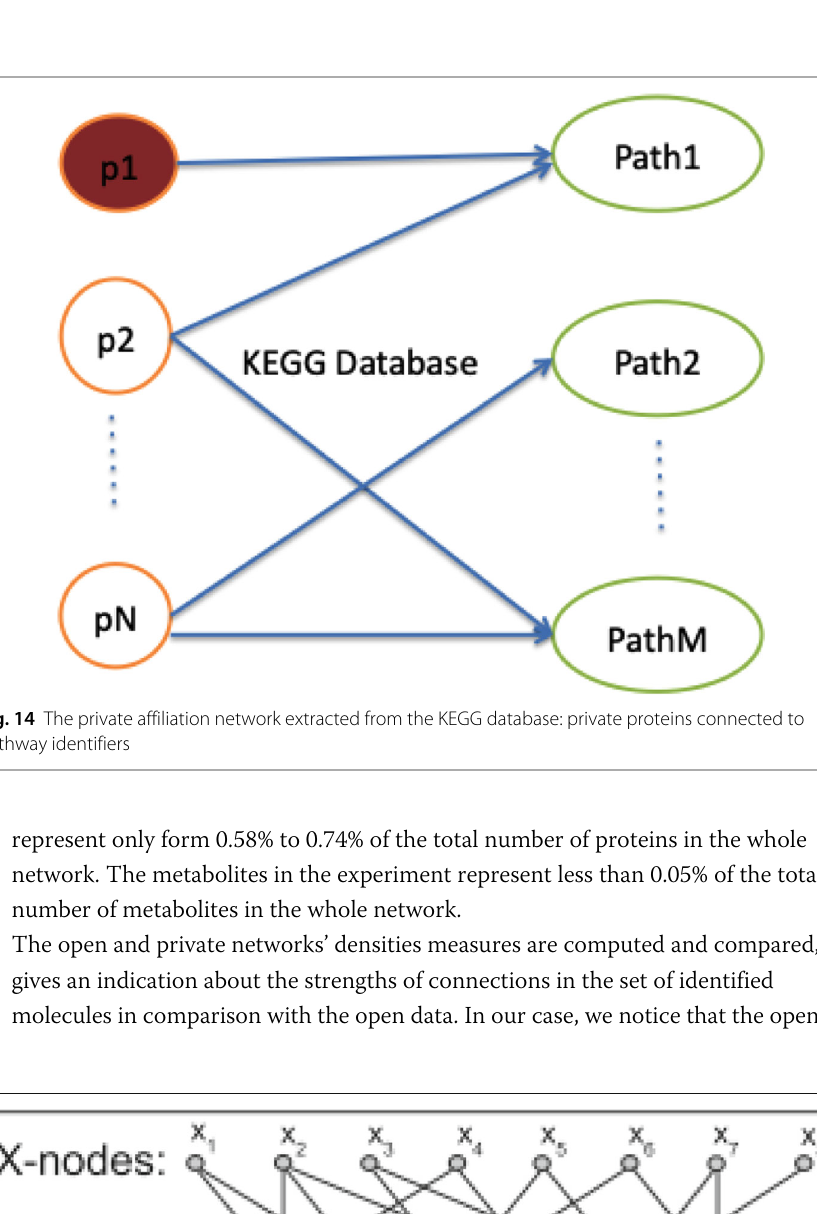
represent only form 0.58% to 0.74% of the total number of proteins in the whole network. The metabolites in the experiment represent less than 0.05% of the total number of metabolites in the whole network.